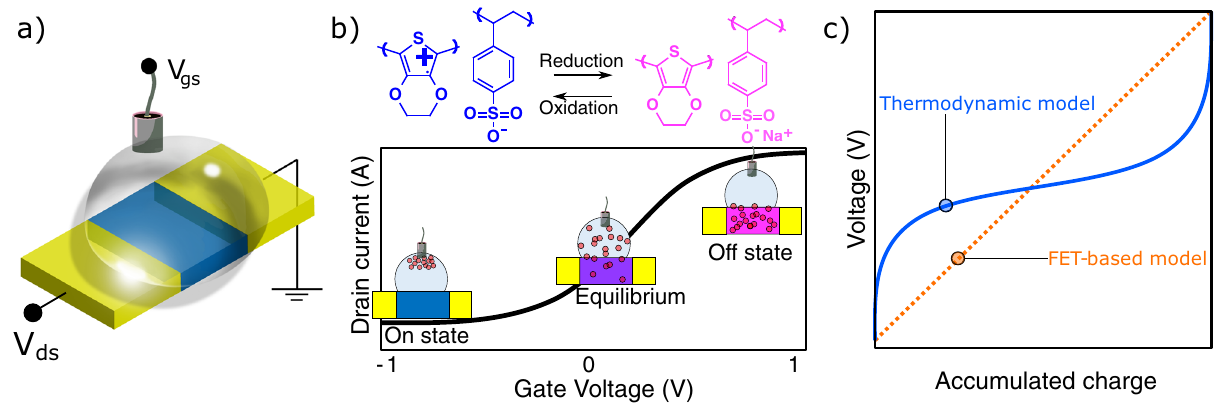
Fig. 1 | Thermodynamic vs classic model of the OECT capacitance. a Typical setupfortheIVmeasurementofanOECTusinganon-polarizableAg/AgClpelletas a gate electrode. Such setup is used throughout this work too. b Redox reaction drivingtheoperationofOECTs.Theamountofoxidizedandreduced PEDOTleads